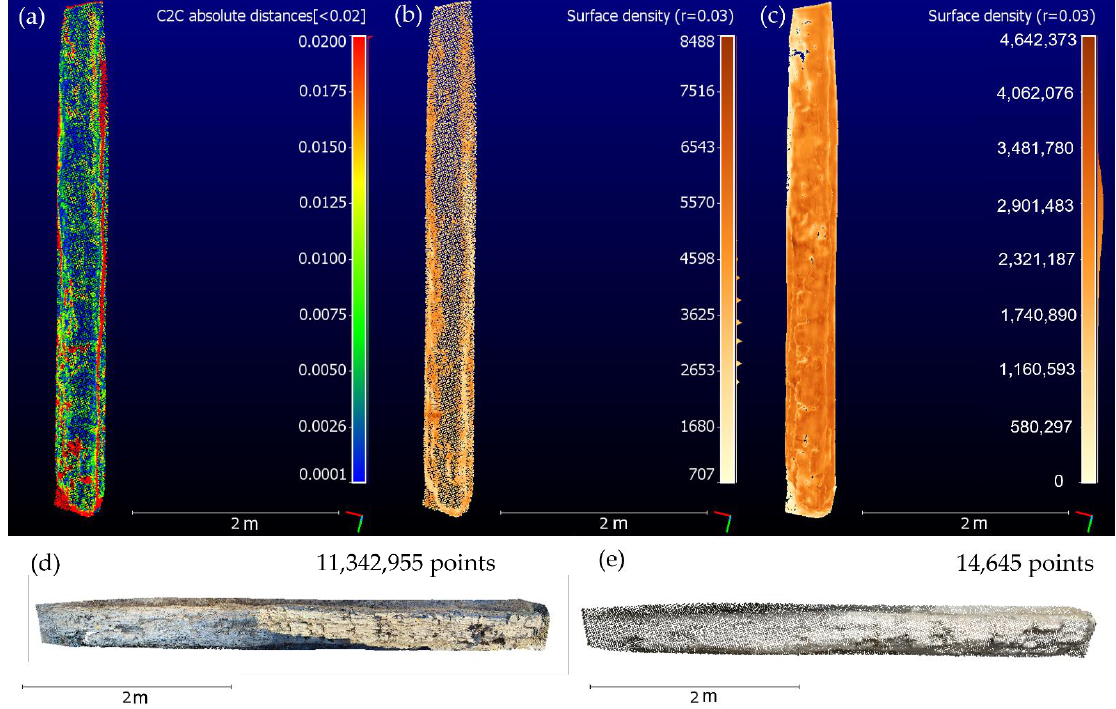
Figure 6. Point clouds of the fossilized trunk comparison: ( a ) cloud to cloud distance, ( b ) surface density of PPT-1, ( c ) surface density of PPT-2, ( d ) RGB point cloud of PPT-1, and ( e ) RGB point cloud of PPT-2.4. VR Geovisualization.